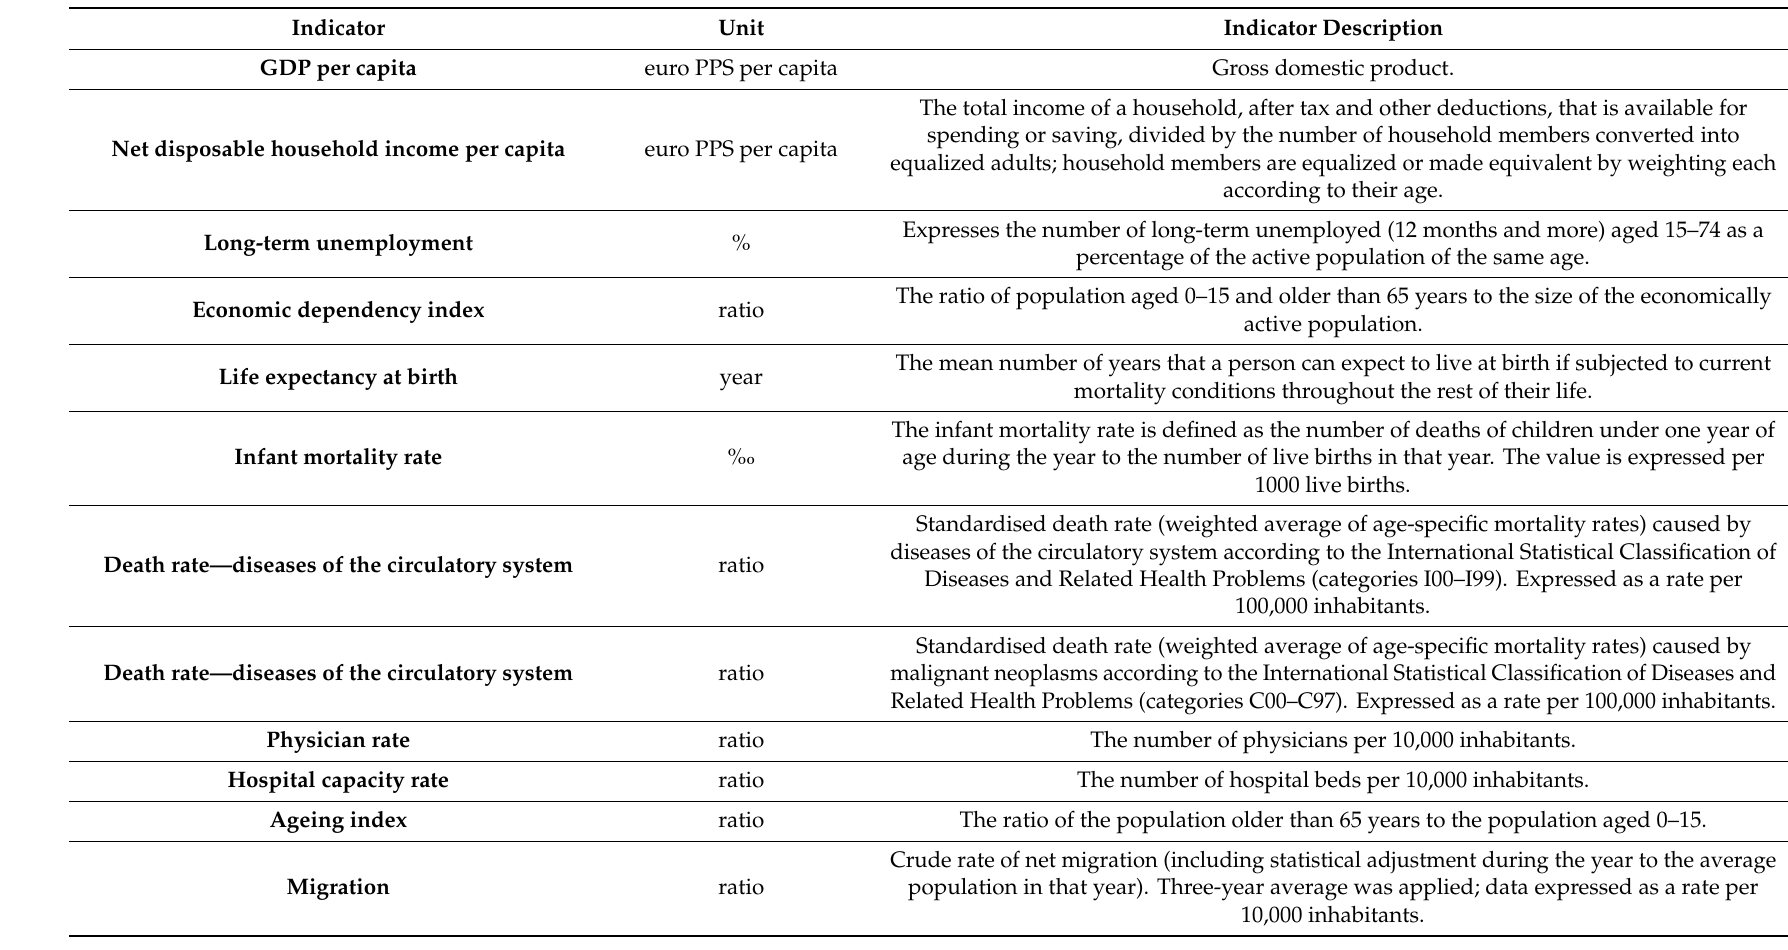
Table A1. List of objective indicators with their